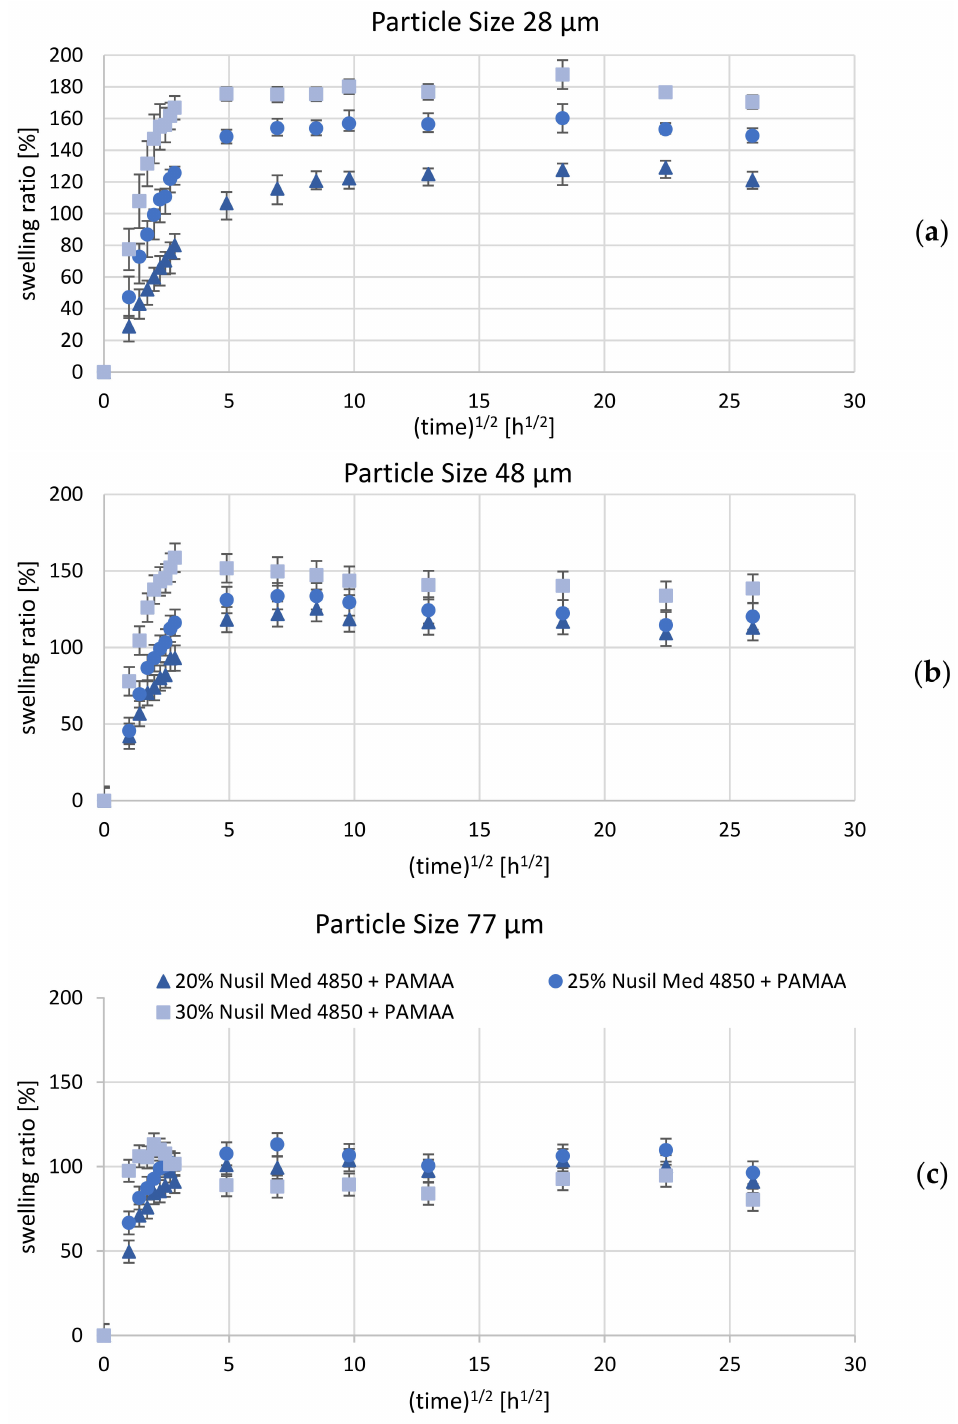
Figure 6. Mean swelling ratio over square root of time (total swelling hours: 672) for Nusil Med 4850-PAMAA composite samples with initial hydrogel content of 20 wt%, 25 wt%, and 30 wt%. Error bars indicate standard deviation for test samples with hydrogel particle size (median) of ( a ) 28 µ m, ( b ) 48 µ m, and ( c ) 77 µ m. For each material combination, n = 6 samples were